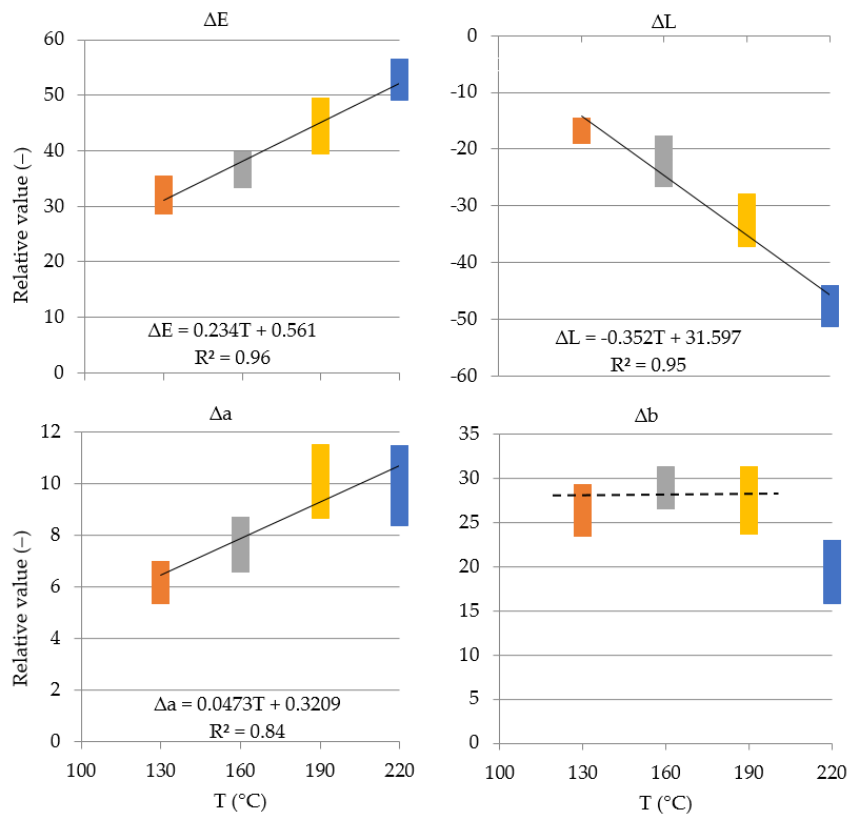
Figure 3. Changes in ∆E, ∆L, ∆a and ∆b in the function of modification temperature